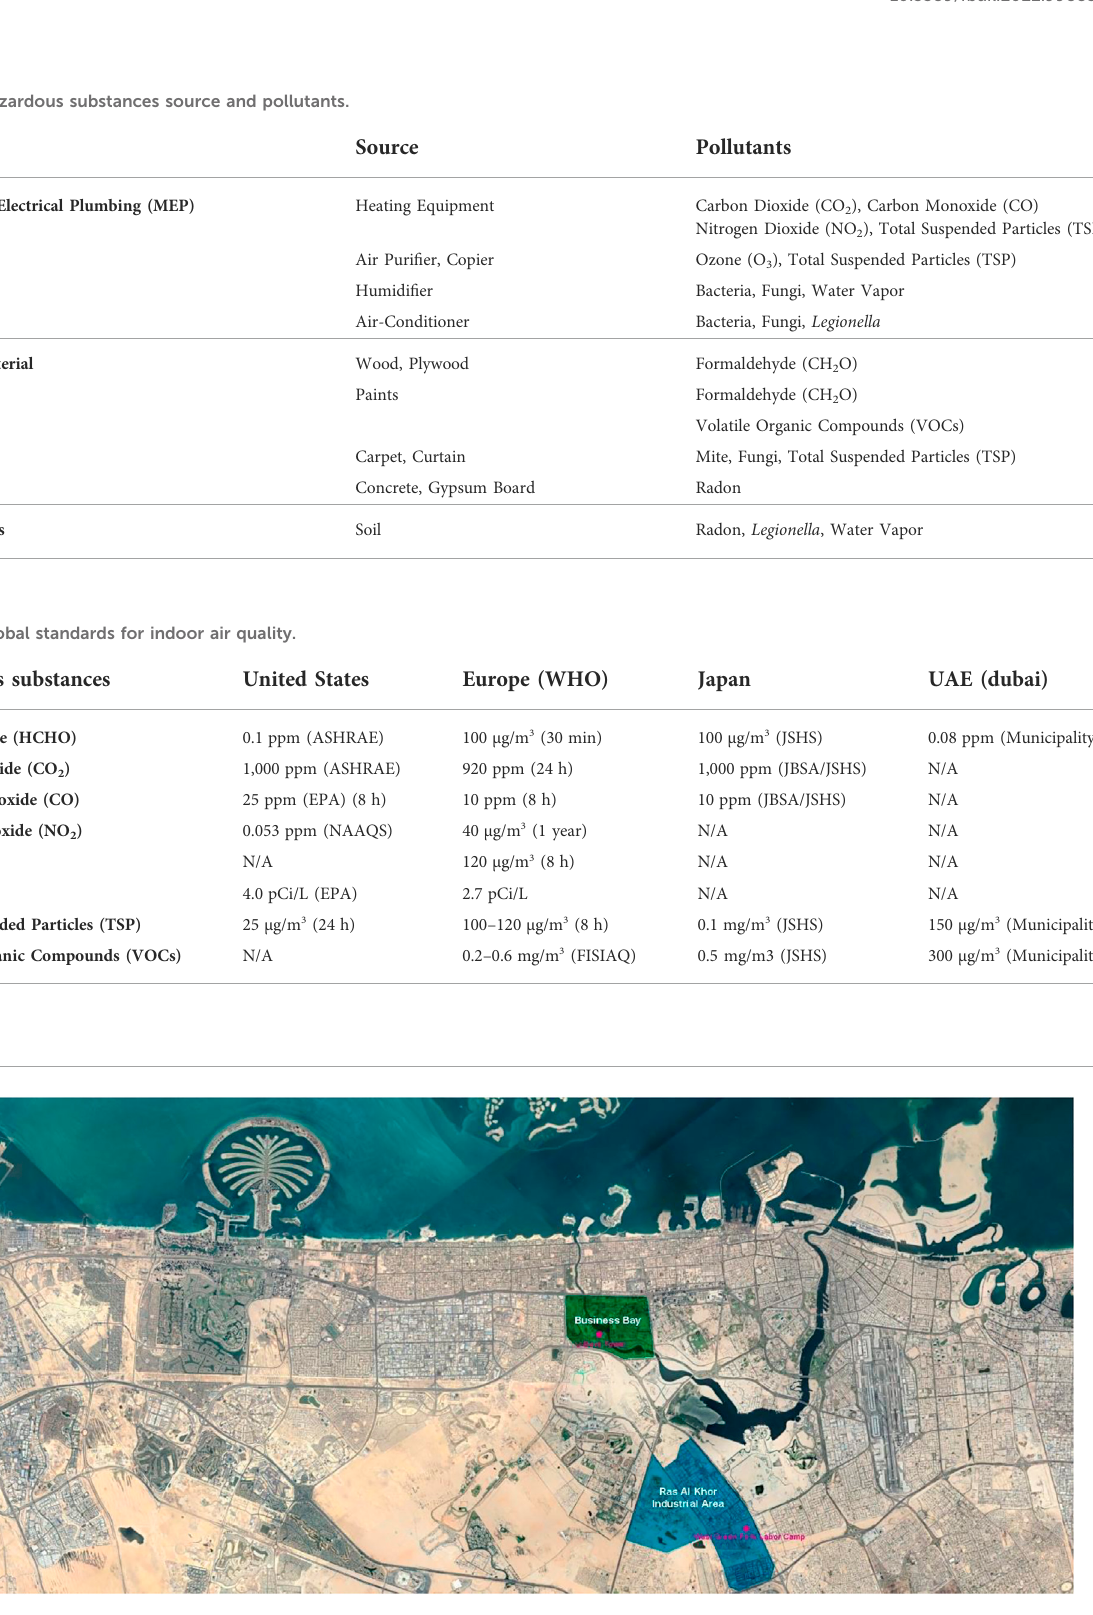
FIGURE 1 The location of U-bora tower at business bay and wasl green park labor camp at ras Al khor industrial area.